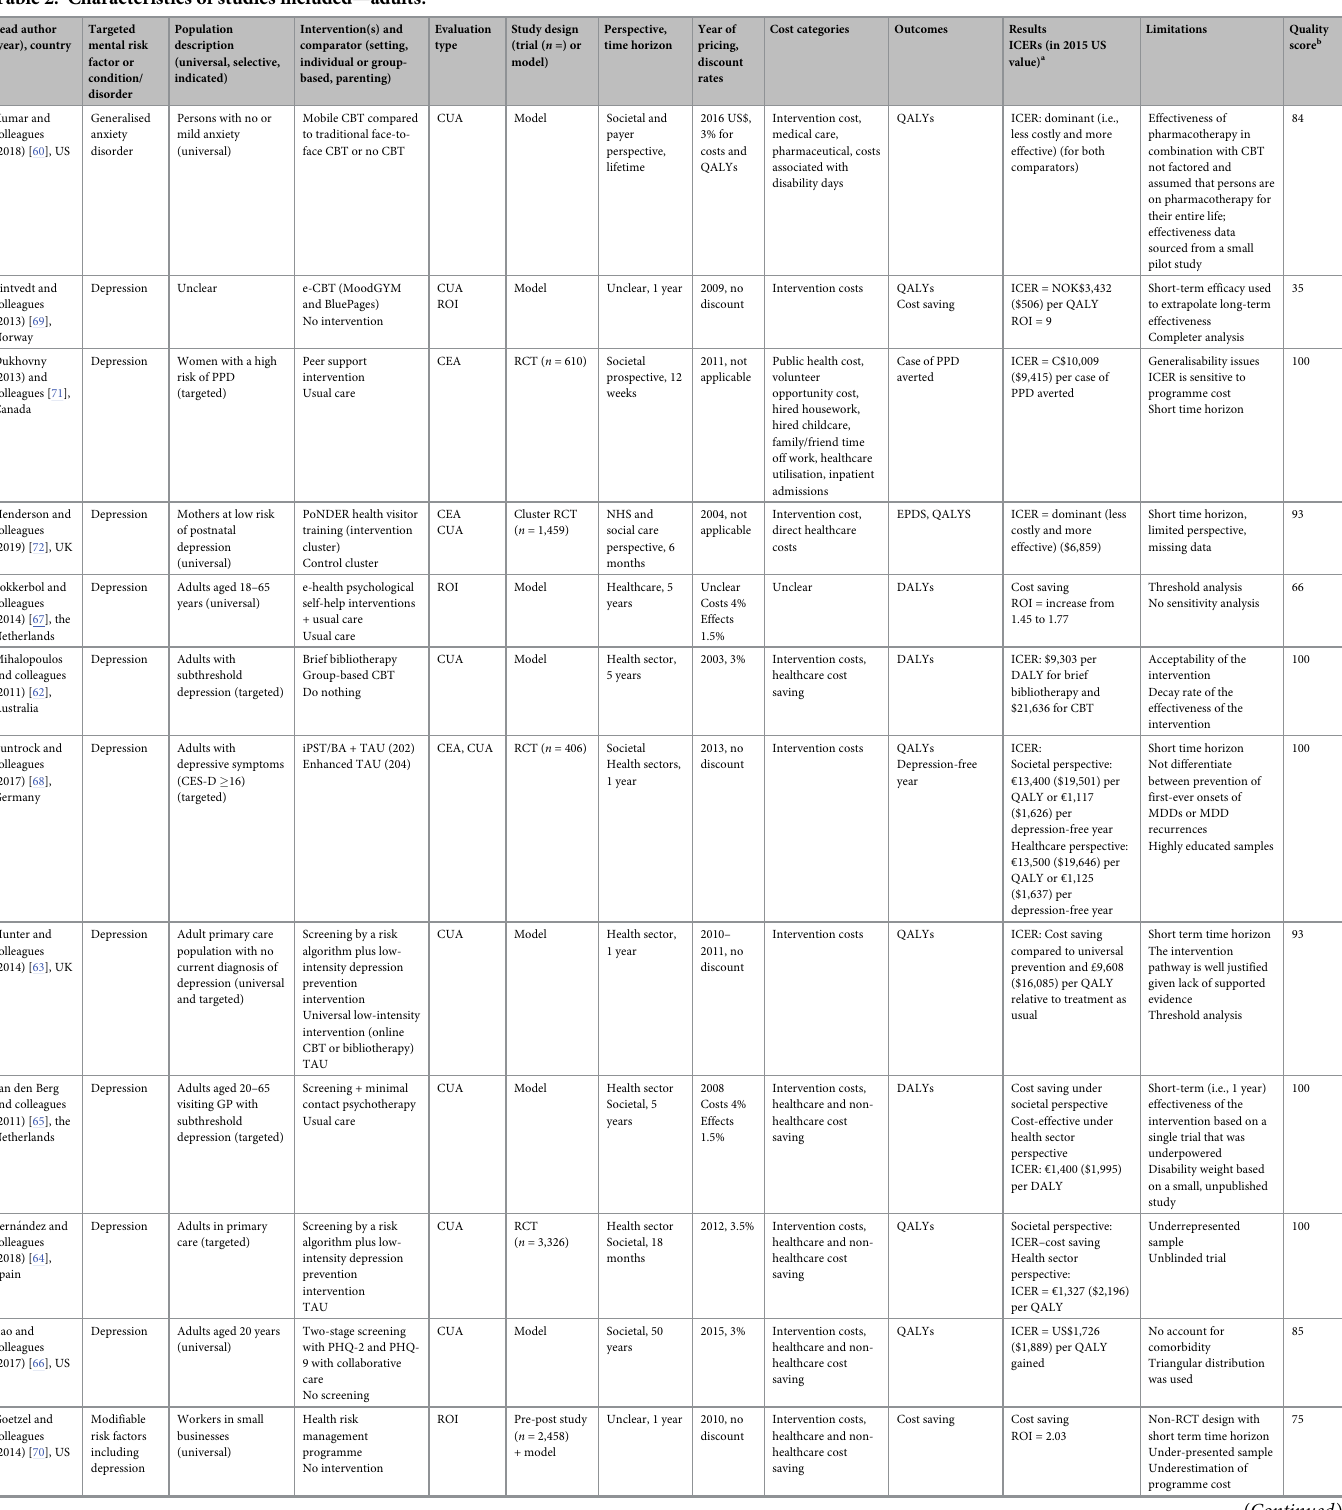
Table 2. Characteristics of studies included—adults. Leadauthor Targeted (year),country mentalrisk factoror condition/